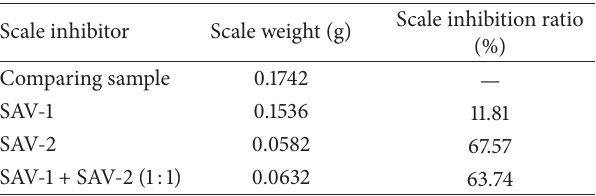
Table 5: Experimental results of scale inhibitor on the inhibition of sodium fluosilicate